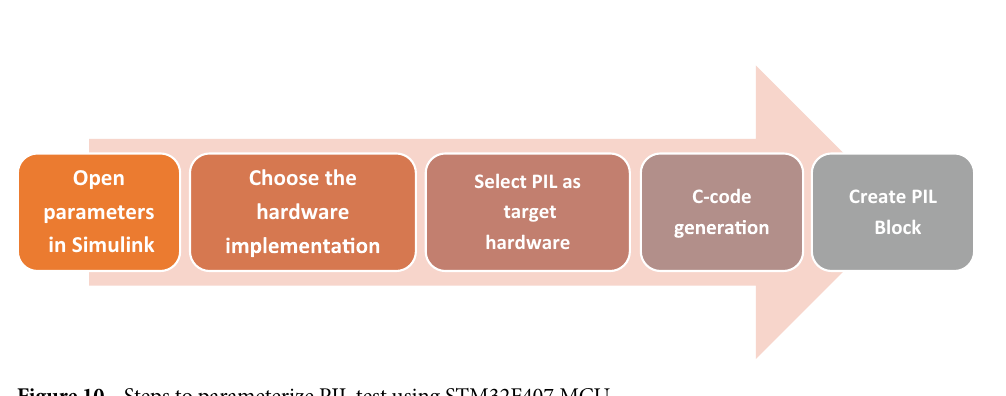
Table 5. Comparative results between FDTC and FDTCO.